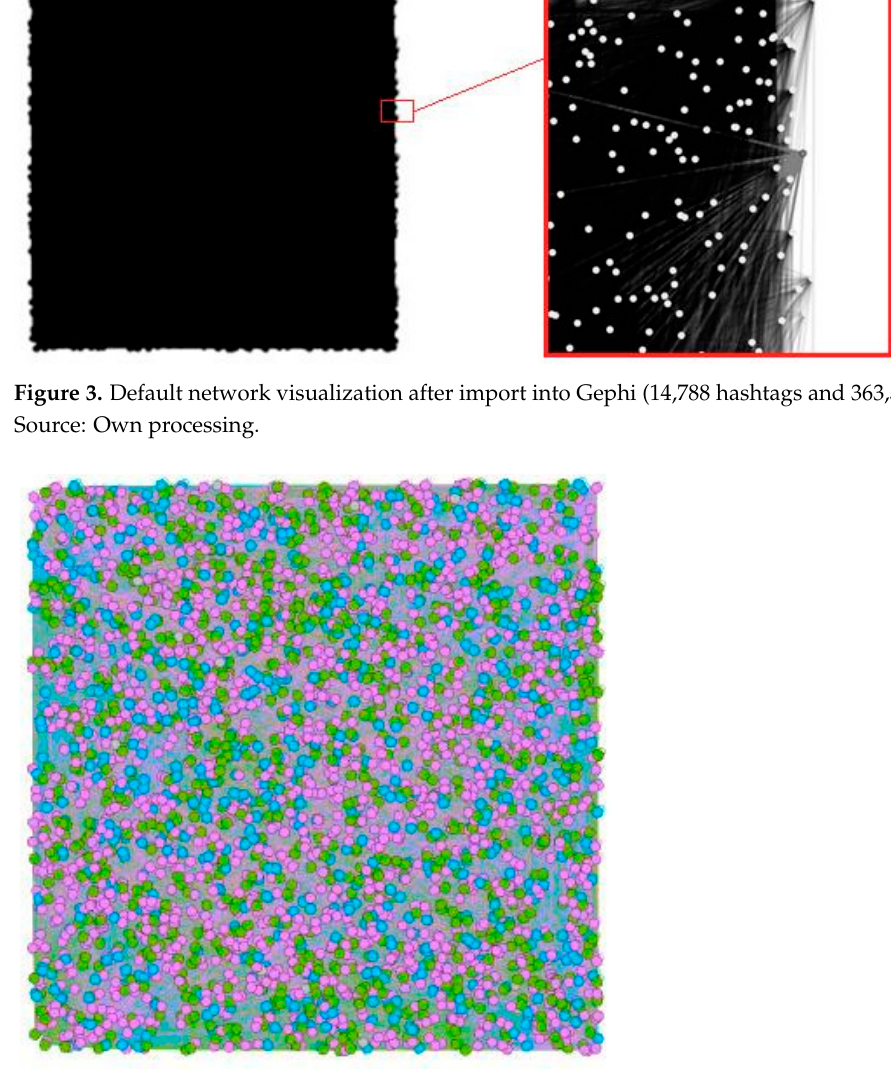
Figure 4. Network visualization in Gephi after modularity calculation without application of algo- rithm for layout visualization (14,788 hashtags and 363,525 edges). Source: Own processing.